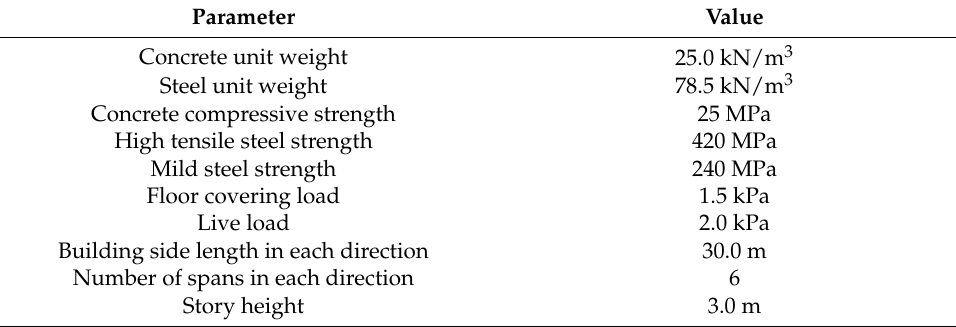
Table 1. Input parameters for the tuning design